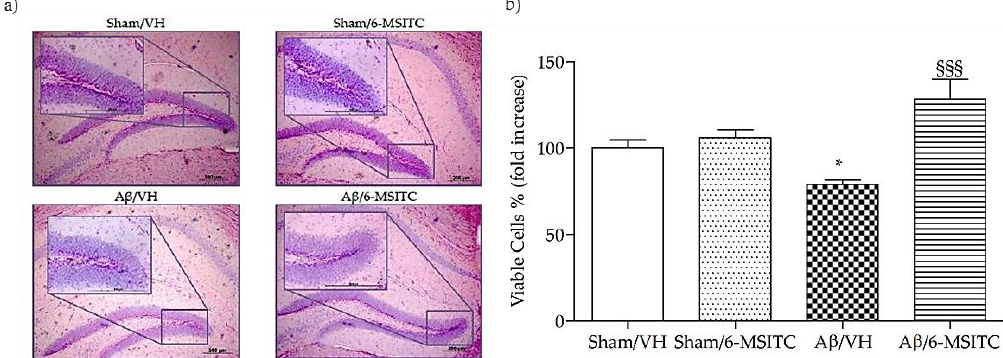
Figure 4. Effects of 6-MSITC (5 mg/kg) on neuronal cell death 20 days after A β 1-42 O injection. Representative H&E staining of coronal sections containing the hippocampus. Magnification 10 × and 40 × , scale bar 200 µ m ( a ). Quantitative analysis of H&E staining ( b ). Values are expressed as mean of fold increase ± SEM ( n = 10) of the density of each experimental group compared to Sham/VH group ( b : * p < 0.05 vs. Sham/VH, §§§ p < 0.001 vs. A β /VH; ANOVA, post hoc test Bonferroni).